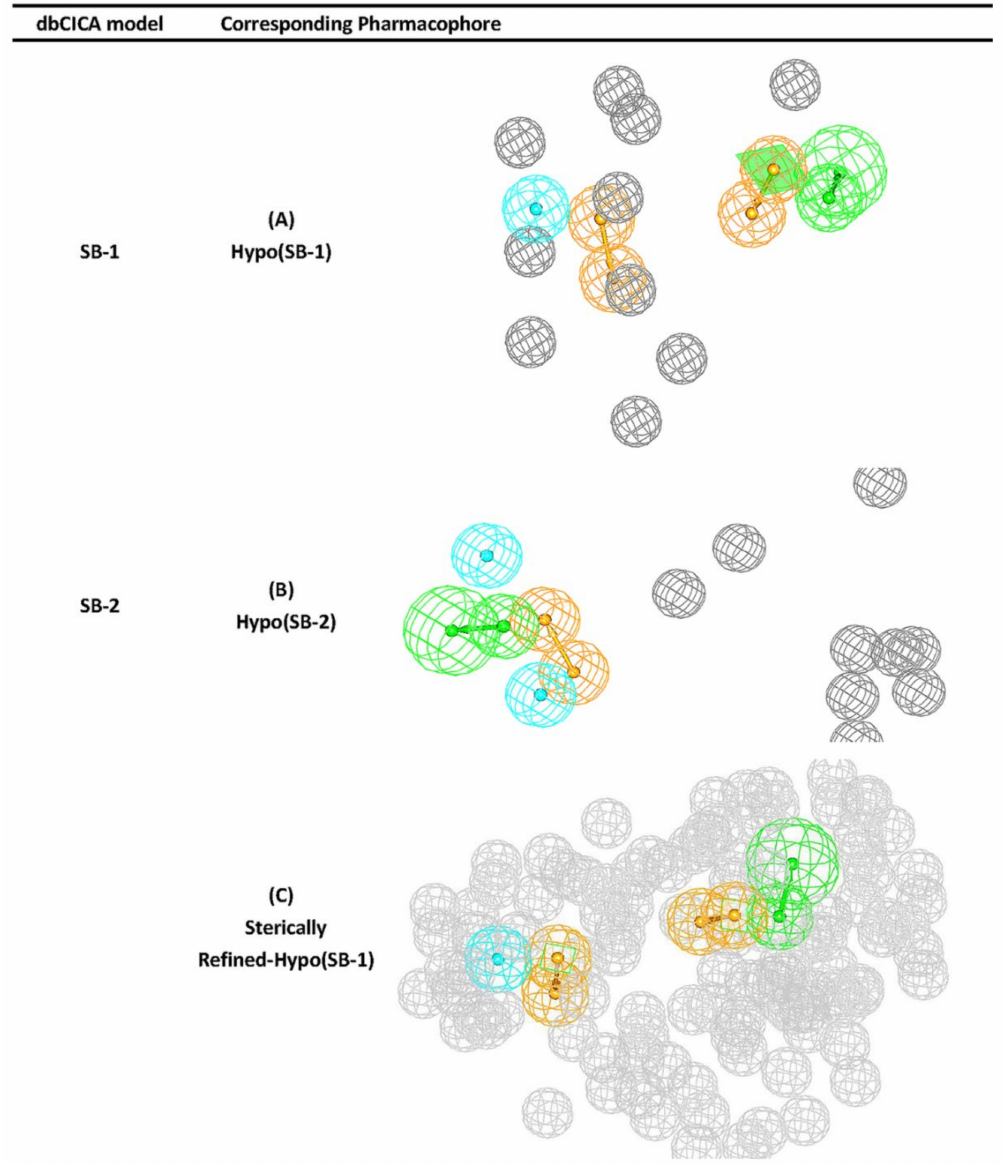
Figure 2. Successful dbCICA models, their corresponding pharmacophores, and the refined pharmacophore Hypo(SB-1) ( A ) pharmacophore extracted form successful SB-1 model that is based on docking ionized ligands into hydrous binding site using PMF04 scoring function with five features. ( B ) Hypo(SB-2) pharmacophore extracted form successful SB-2 model that is based on docking ionized ligands into unhydrous binding site using Ligscore2 scoring function with ten features and ten exclusion volumes. ( C ) Sterically-refined version of Hypo(SB-1) includes 93 exclusion spheres that are shown as grey spheres (1.2 Å tolerance radii). Light blue sphere represents Hbic (hydrophobic feature), orange-vectored spheres represent ring aromatic feature, green-vectored spheres represent hydrogen bond acceptor (HBA), and gray spheres represent exclusion